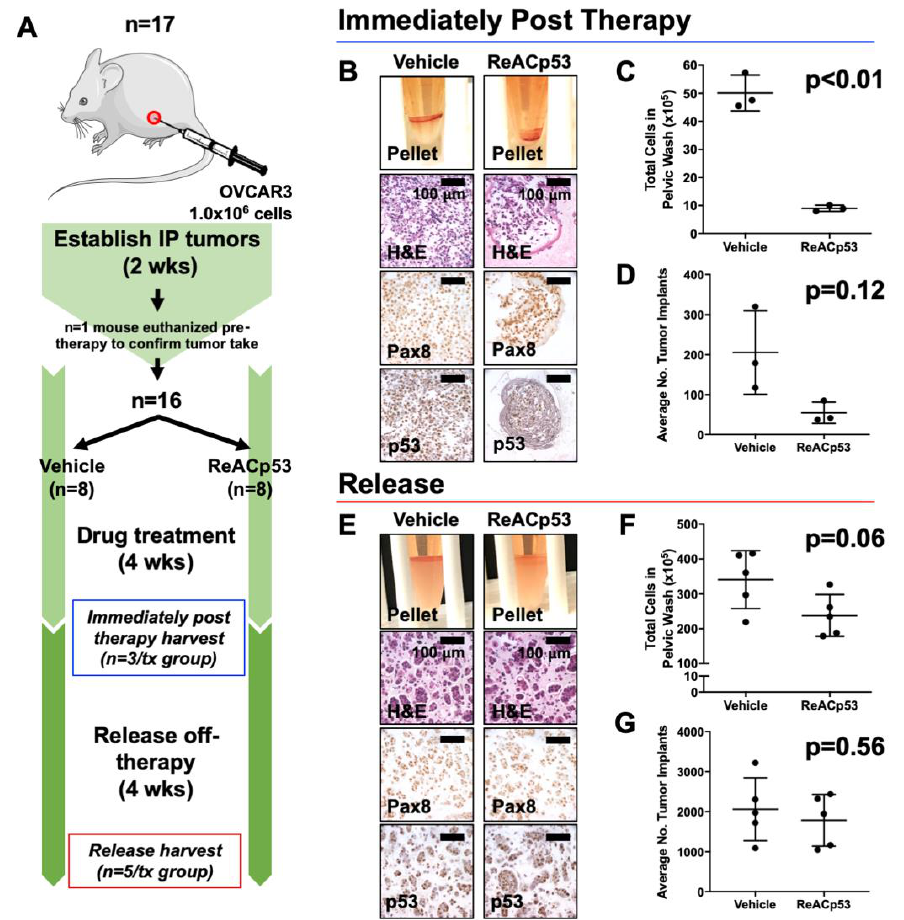
Figure 2. Resurgence of tumors after cessation of ReACp53 therapy in vivo. ( A ) Xenografts were established by injecting 1.0 × 10 6 OVCAR3 cells into the intraperitoneal (IP) space of n = 17 NSG mice. Tumor take was confirmed in n = 1 mouse after two weeks of tumor establishment. The remaining mice (n = 16) were randomized to receive either vehicle or ReACp53 15 mg/kg 3 × /week IP for four weeks (n = 8/treatment). A cohort of mice was harvested after four weeks of treatment (n = 3/treatment, immediately post-therapy cohort). The remaining mice were released off-therapy and euthanized four weeks later (n = 5/treatment, release cohort). ( B – D ) Results from mice harvested immediately post-therapy. ( B ) Representative cell pellets harvested from euthanized mice. Tumors cells were confirmed by Pax8 and p53 staining. (C) The total number of cells harvested was quantified for each mouse. Results demonstrated a lower tumor burden in mice treated with ReACp53 vs.